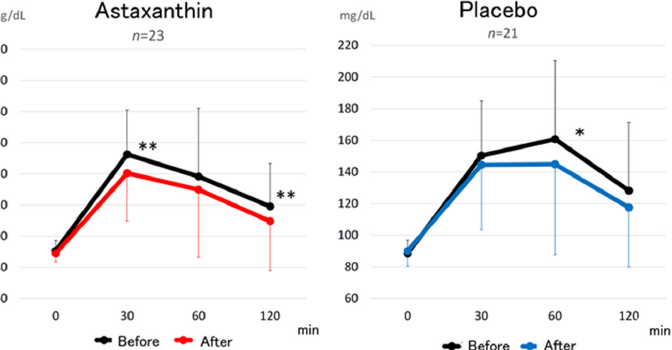
Figure 3. Changes in the plasma glucose concentration based on 75 g OGTT before and after supplementation with 12 mg ASTX for 12 weeks. Figure 4a shows the results in all subjects. Figure 4b shows the results in subjects with prediabetes, whose HbA1c range was from 5.6 to 6.4. All data are presented as the mean ± standard deviation. The Wilcoxon signed-rank test was used to test for significant differences within each group. *: p < 0.05, **: p < 0.01.